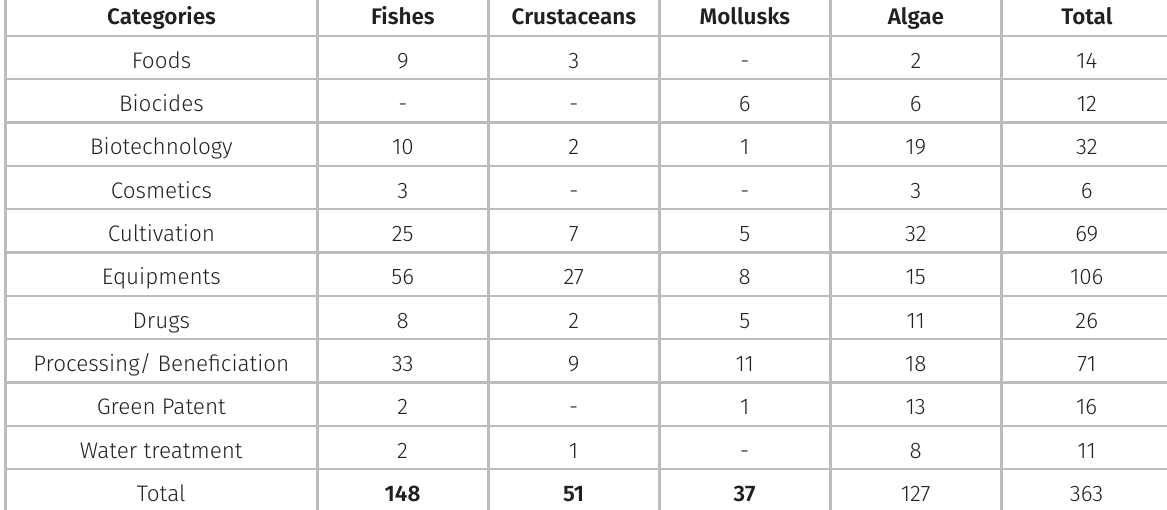
Table II. Number of patents relating to fisheries resources and their respective areas of application based on a survey carried out in the INPI database. –: no results